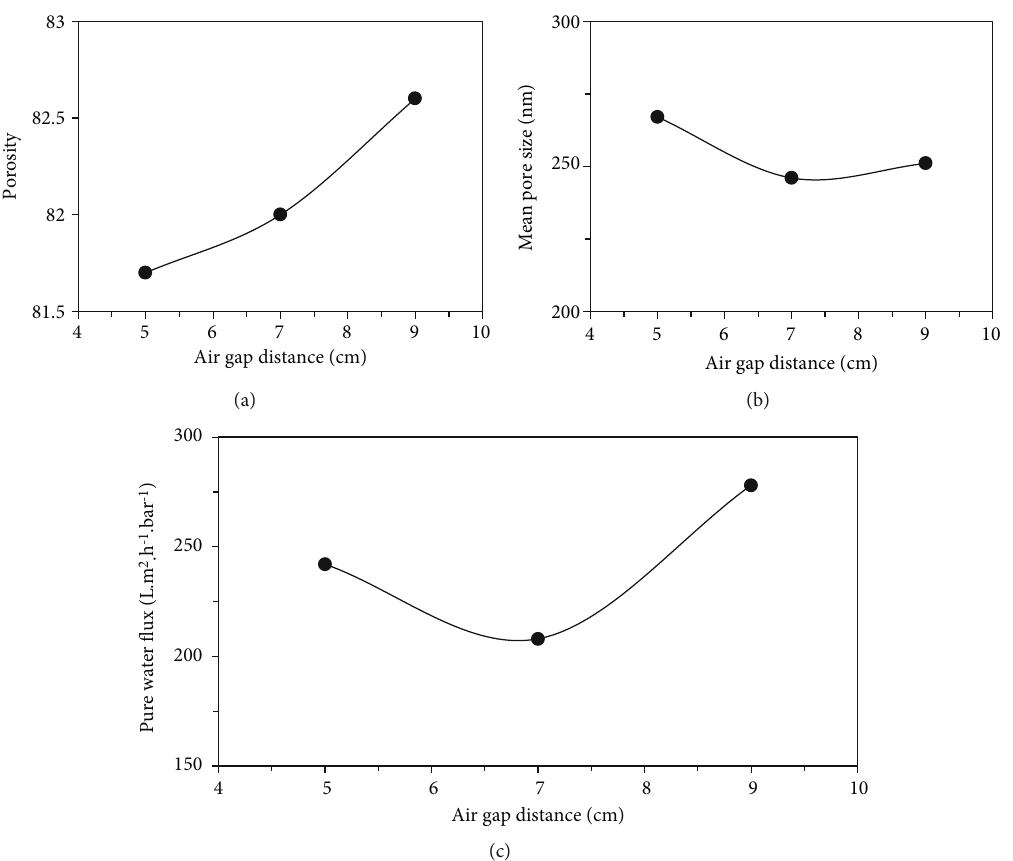
Figure 9: E ff ect of air gap distance on the membrane porosity (a), mean pore size (b), and pure water fl ux (c) of PAN hollow fi ber